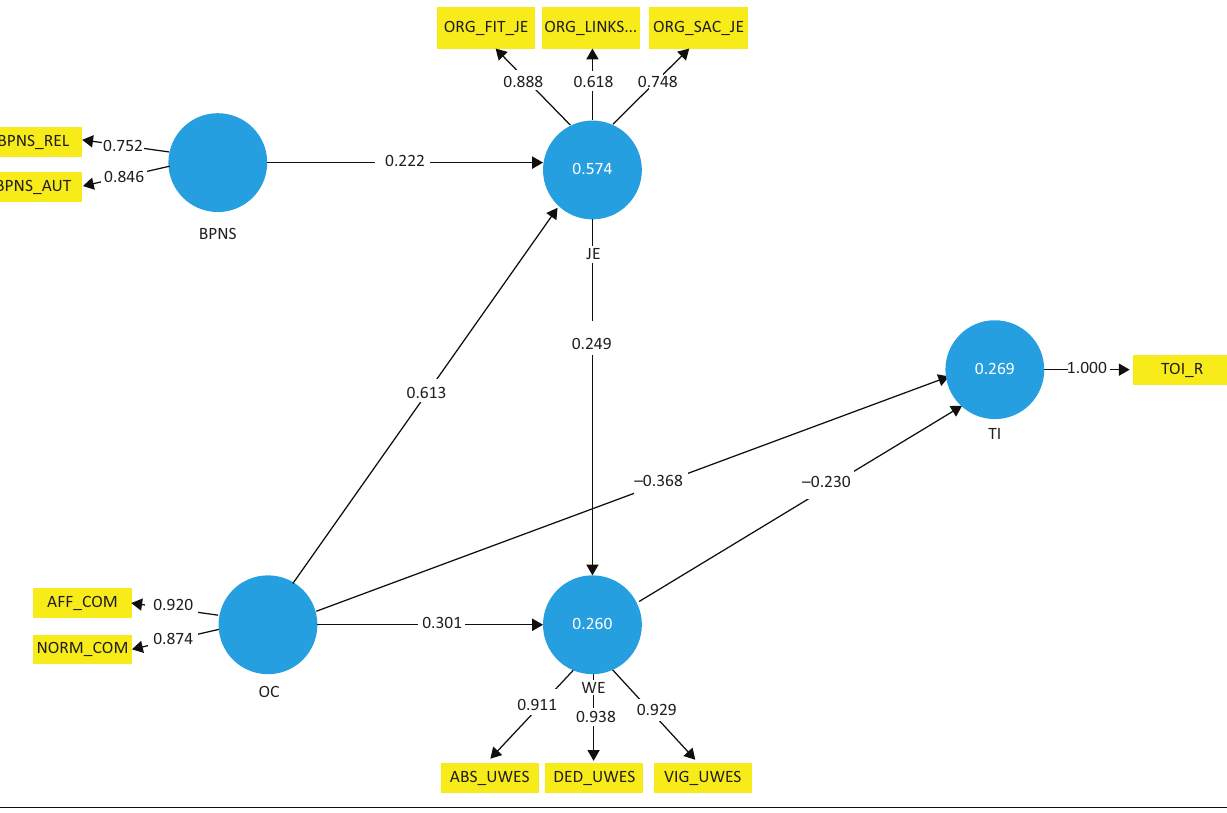
FIG URE 1: The final